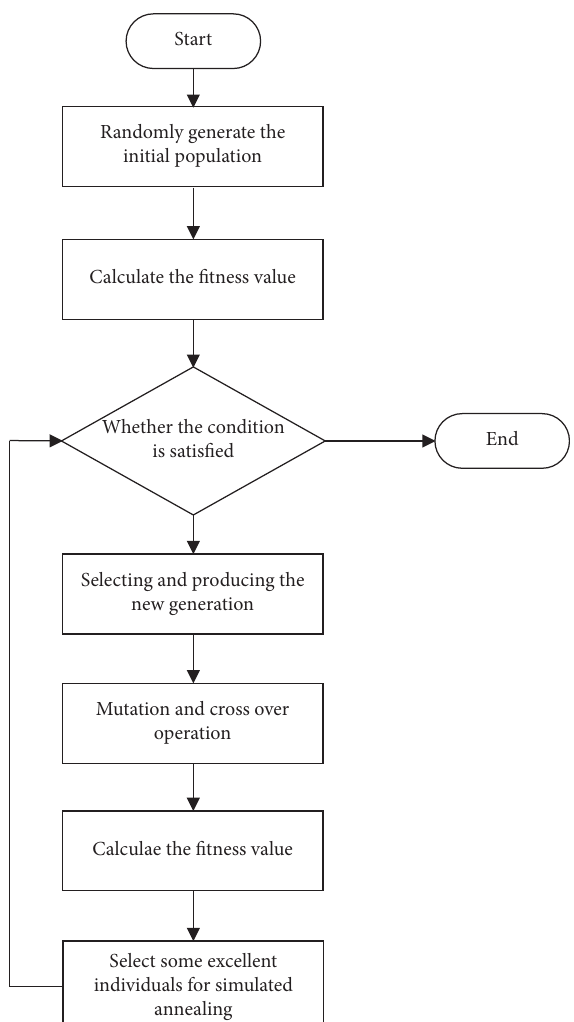
Figure 2: Algorithm operation